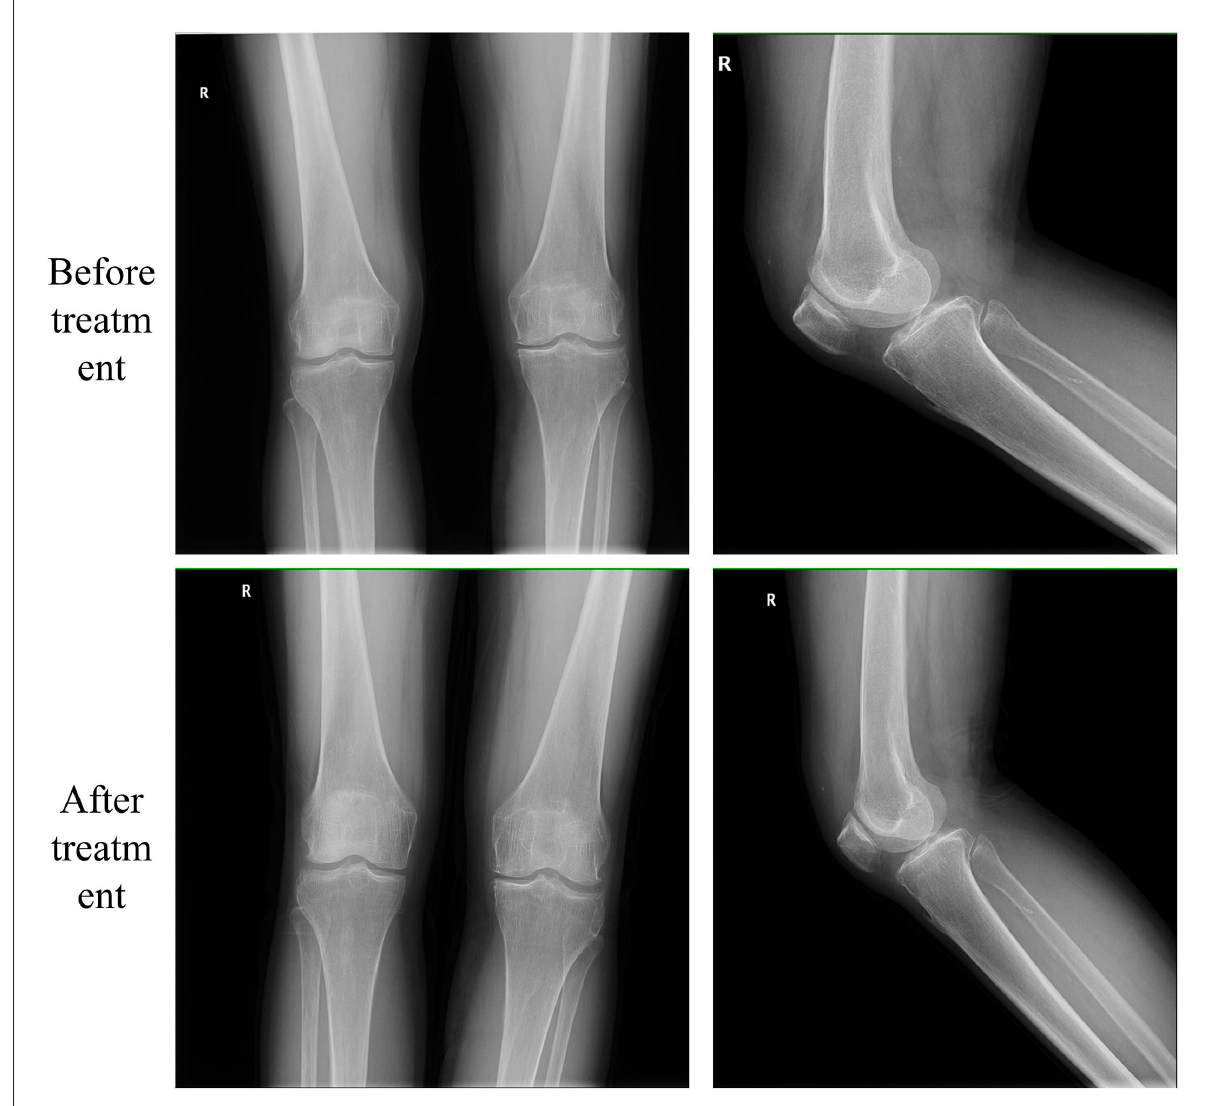
FIGURE1 X-ray before and after treatment. X-rays of the knee before treatment were suggestive of knee osteoarthritis (Grade III on the K–L grading). K–L,